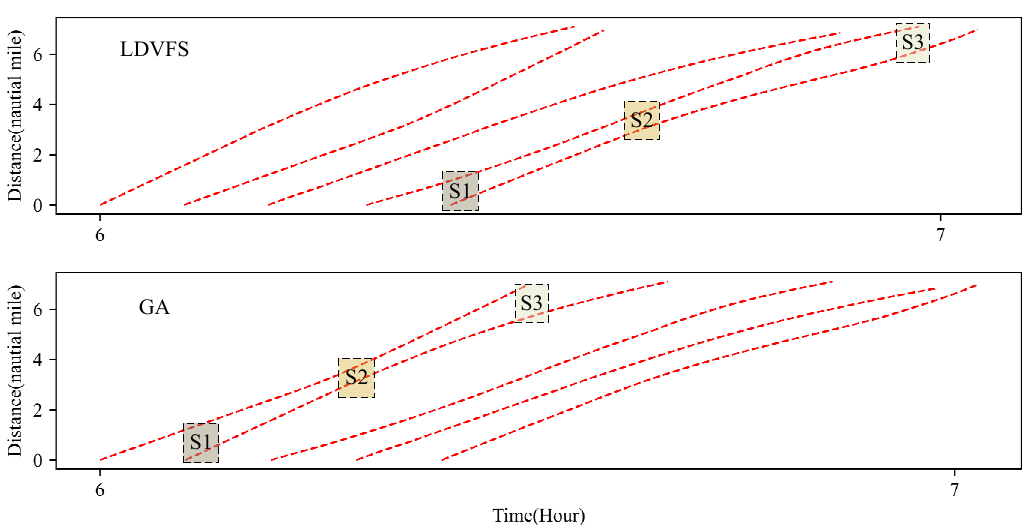
Figure 4. Optimal Gantt for the sample instance.